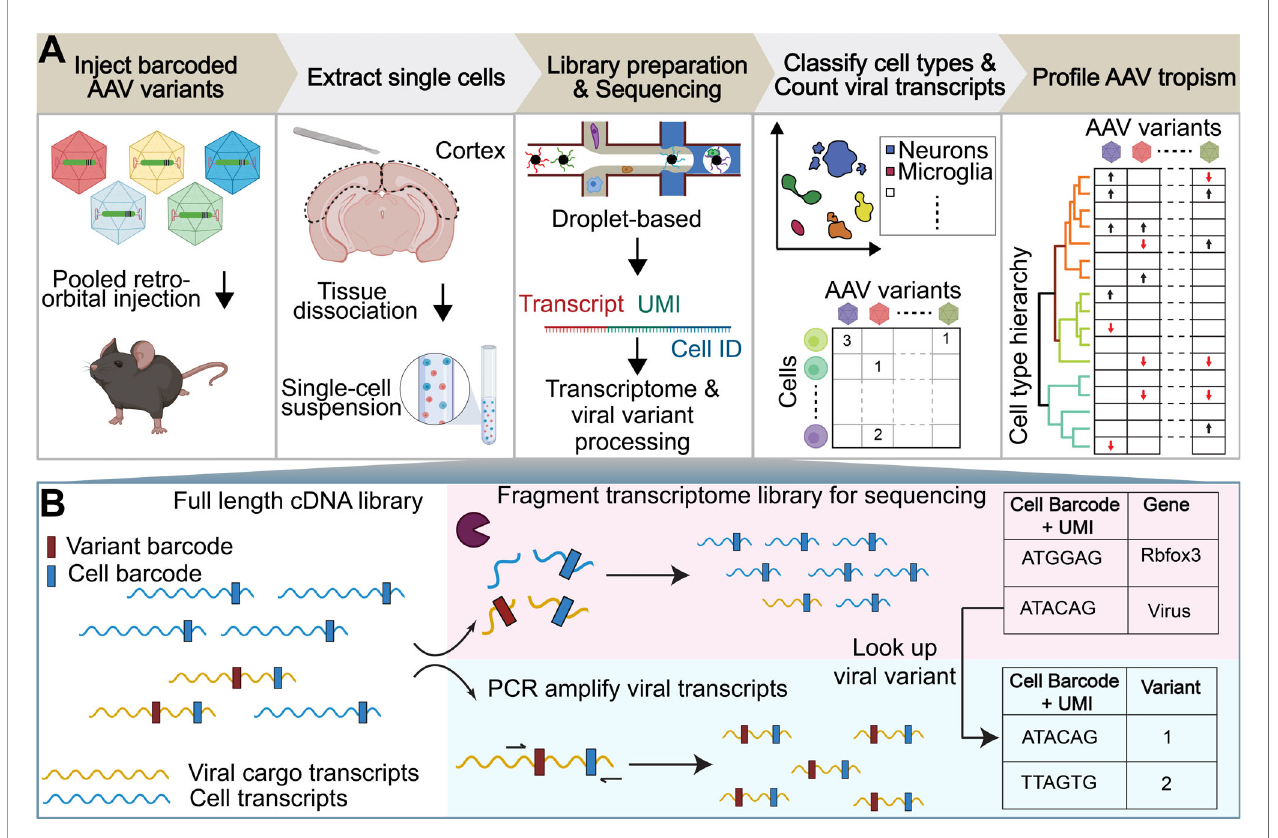
FIGURE 1 | Work fl ow of AAV tropism characterization by scRNA-seq. (A) (I) Injection of a single AAV variant or multiple barcoded AAV variants into the retro-orbital sinus. (II) After 3 – 4 weeks post-injection, the brain region of interest is extracted and the tissue is dissociated into a single-cell suspension. (III) The droplet-based 10x Genomics Chromium system is used to isolate cells and build transcriptomic libraries [see (B) ]. (IV) Cells are assigned a cell-type annotation and a viral transcript count. (V) AAV tropism pro fi ling across numerous cell types. (B) The full length cDNA library is fragmented for sequencing as part of the single-cell sequencing protocol (top). To enable viral tropism characterization of multiple rAAVs in parallel, an aliquot of the intact cDNA library undergoes further PCR ampli fi cation of viral transcripts (bottom). During cDNA ampli fi cation, Illumina sequencing primer targets are added to the viral transcripts such that the sequence in between the Illumina primer targets contains the AAV capsid barcode sequence. Viral cargo in the cell transcriptome is converted to variant barcodes by matching the corresponding cell barcode + UMI in the ampli fi ed viral transcript library